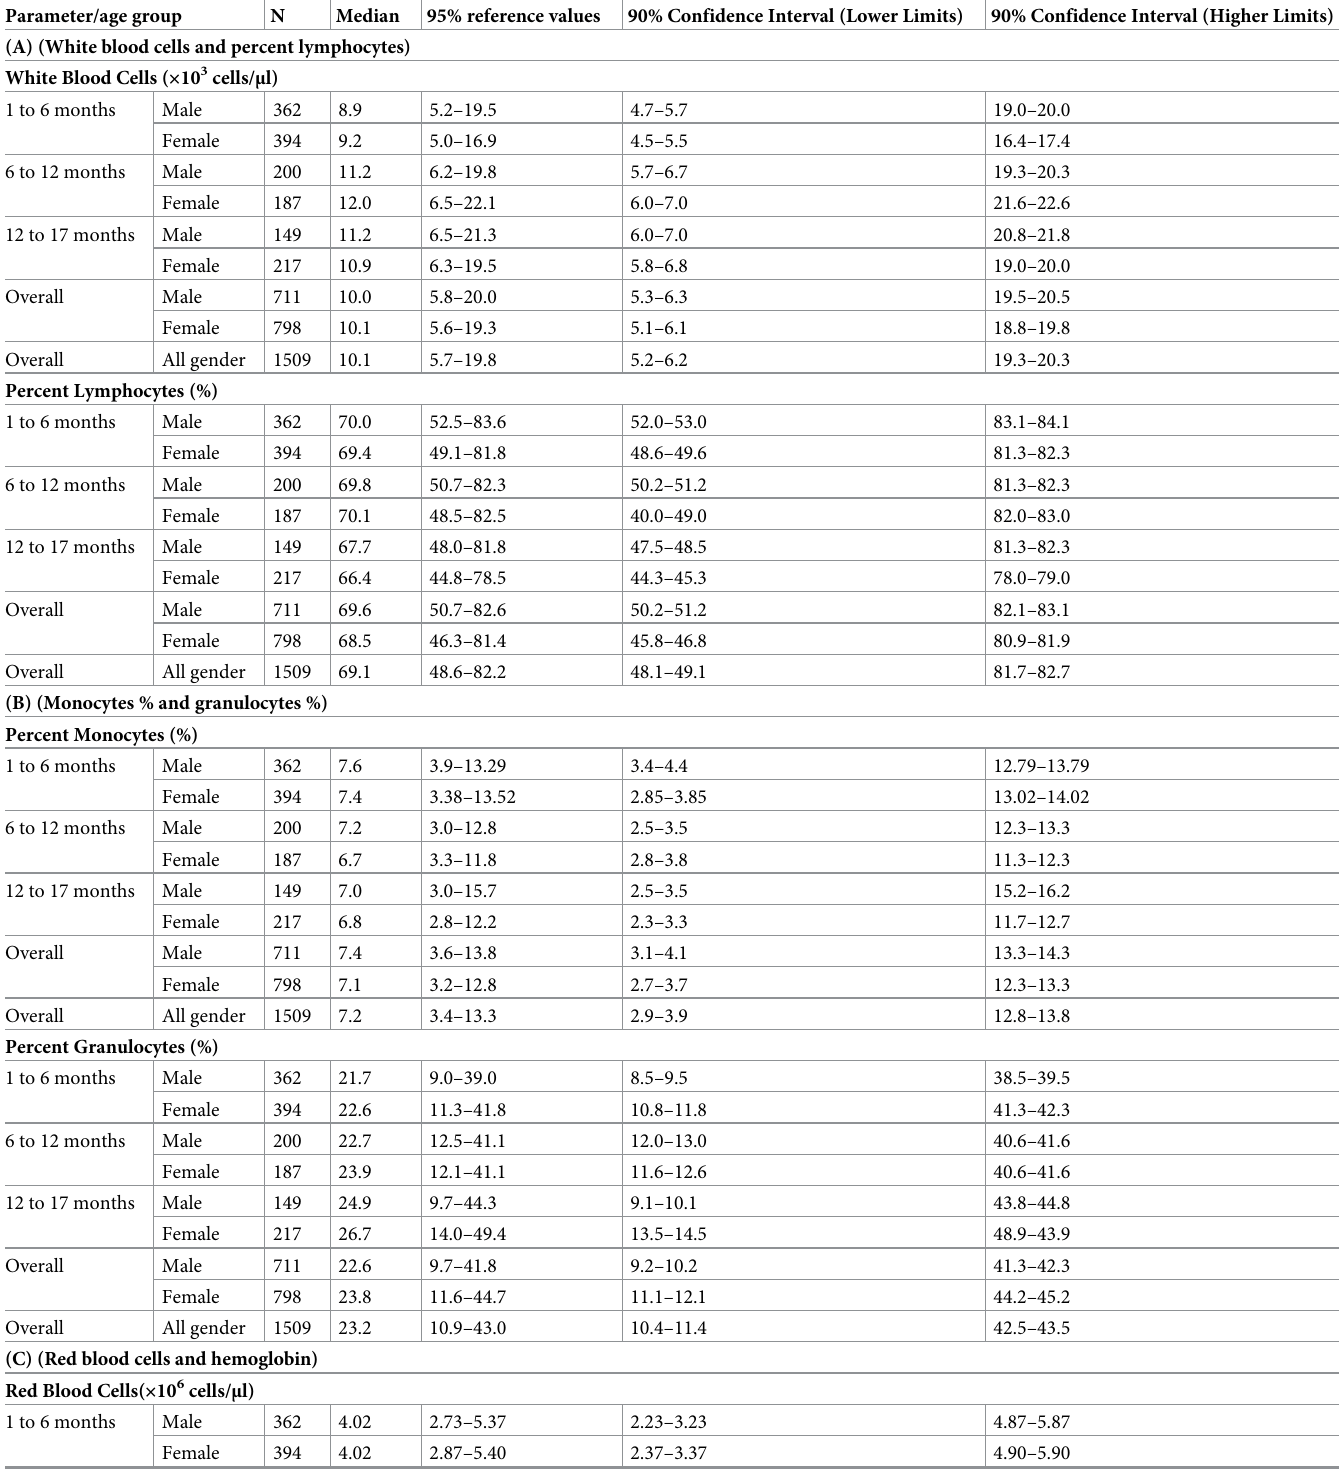
Table 2. 95% hematology reference ranges for hematology analytes in infants aged 1-17 months from Kisumu. Parameter/age